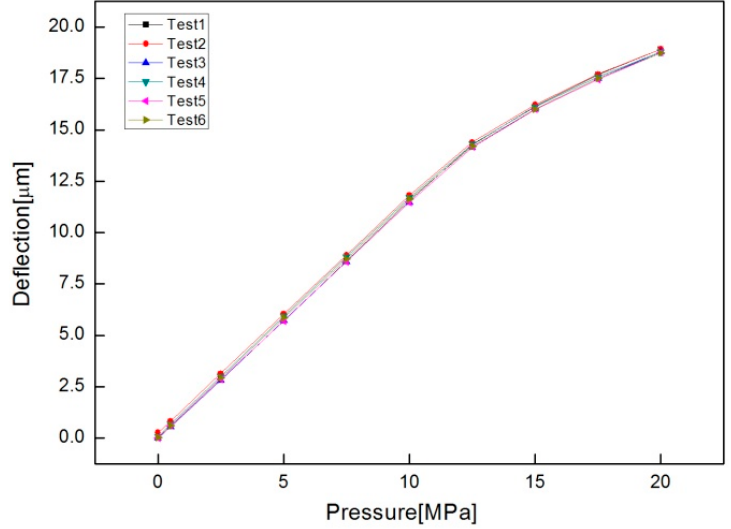
Figure 12. Plot of measured diaphragm deflection with pressure.